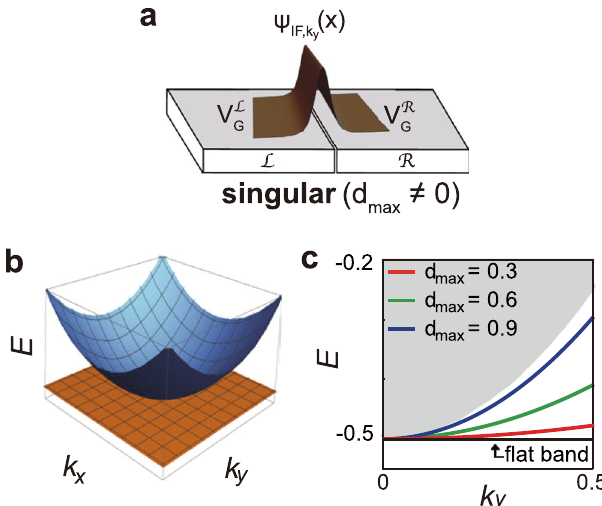
Fig. 1 Singular fl at band and interface modes characterized by the quantum distance. a Schematics of the interface mode. When the fl at band is singular, namely the maximum quantum distance d of the fl at band is max nonzero, an interface mode Ψ IF ; k with a crystal momentum k y appears y between two areas (denoted by L and R ) with different onsite potentials V L and V R . b A fl at band with a parabolic band-crossing. c The band G G spectra of interface modes for various values of d max . The gray region represents the bulk parabolic band. Here, the effective mass tensor of the parabolic band is given by m (cid:2) 1 xx ¼ m (cid:2) 1 yy ¼ 2, m (cid:2) 1 xy ¼ 0, and the onsite potentials are set to be V L ¼ 0 and V R ¼ (cid:2) 0 : G G